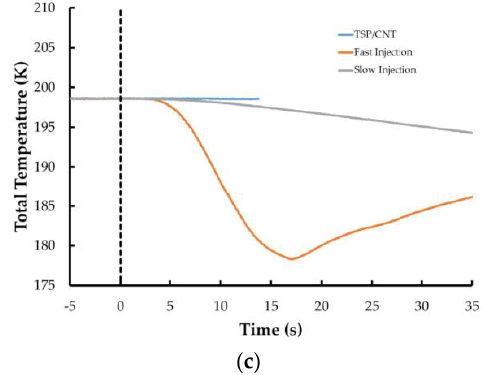
Figure 15. Tunnel conditions during the temperature step introduced using the different methods. The start of the injection is marked at t = 0 s: ( a ) Mach number; ( b ) Reynolds number; and ( c ) total temperature.